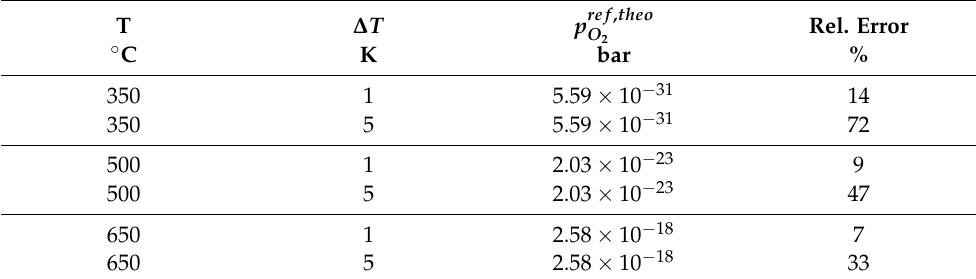
Table 2. Theoretical reference oxygen partial pressure values p ref , theo peratures and resulting relative errors due to an assumed uncertainty in temperature measurement, given by ∆ T